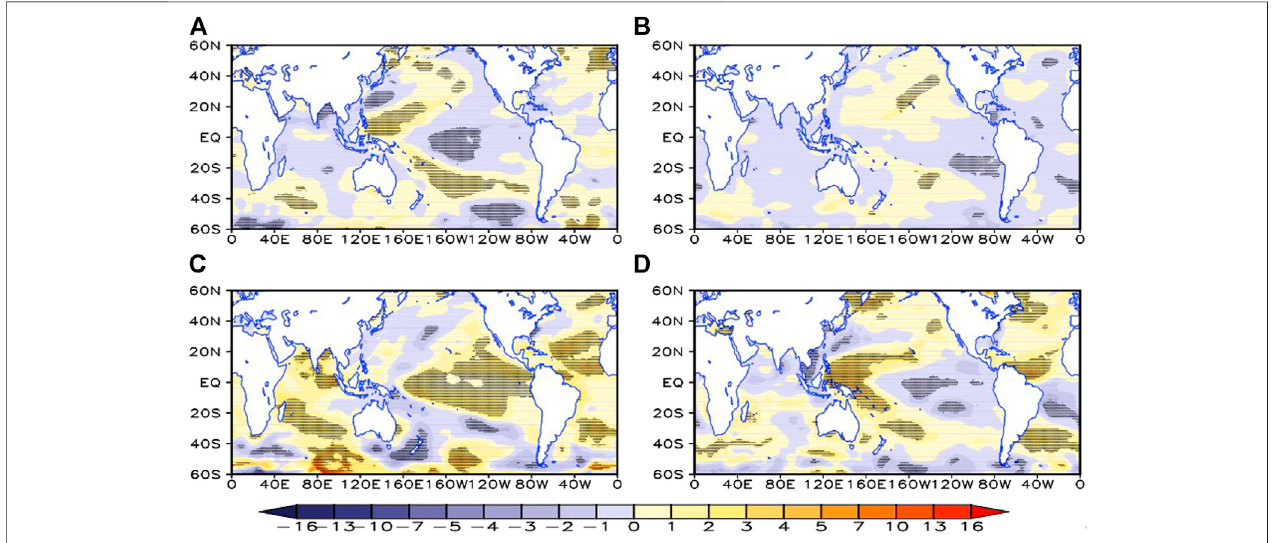
FIGURE 6 | Regression coef fi cient fi eld of the PRR in the MLRYR and the SST in (A) spring, (B) summer, (C) autumn and (D) winter (units: %/K). The dotted area indicates that it passed the 95% signi fi cance test.